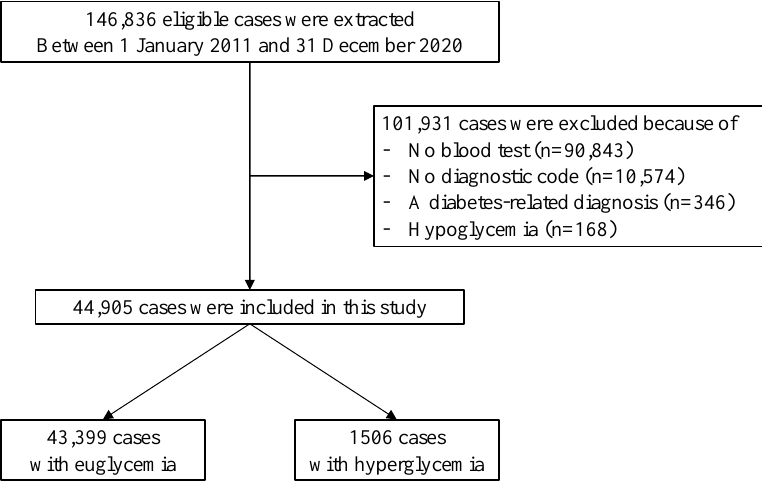
Figure 1. Flowchart of the study population.